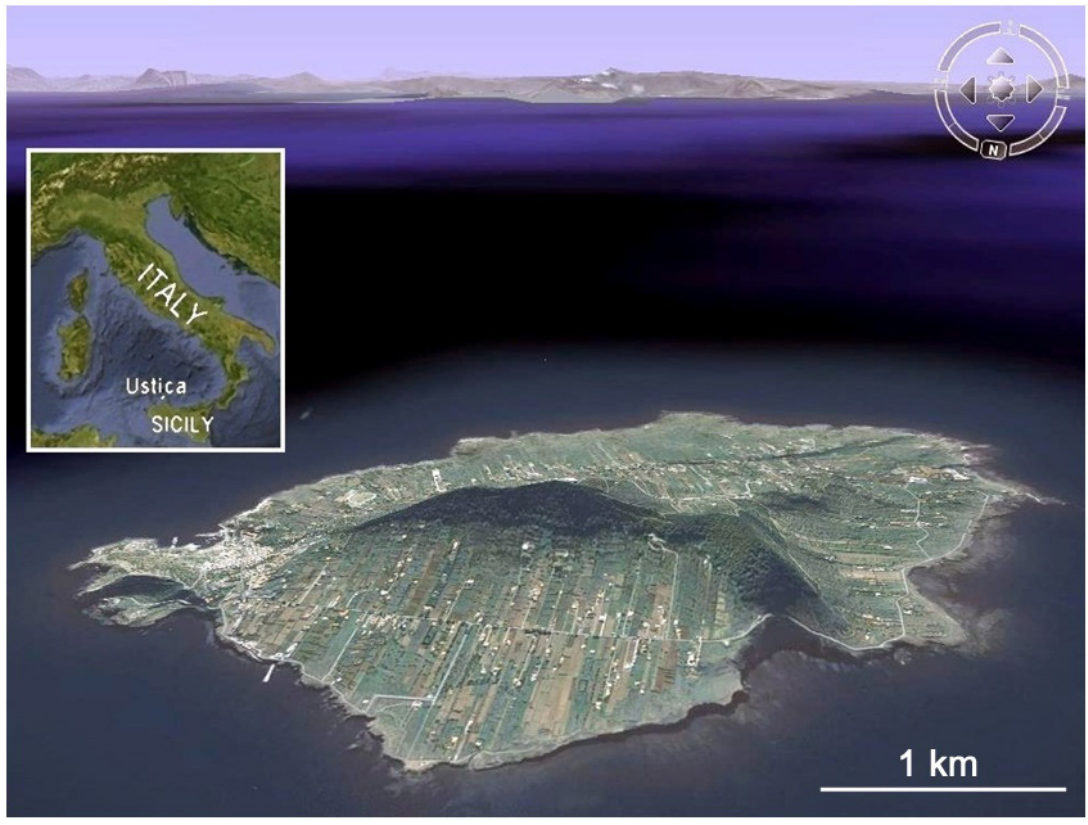
Figure 1: The island of Ustica and the north-western coast of Sicily visible on the horizon. From Google